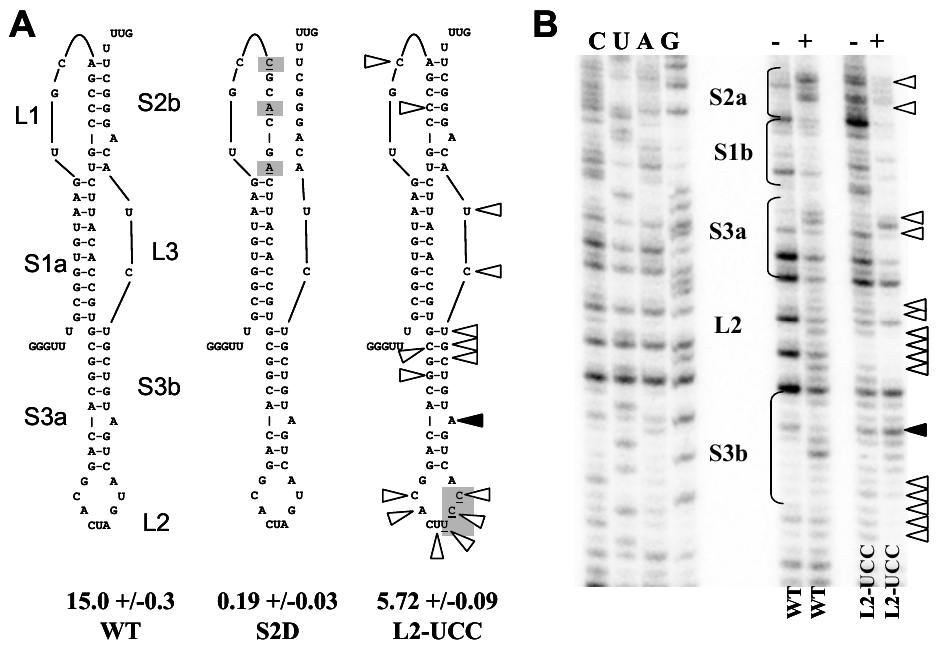
Figure 3. Mutations to stem 3 alter pseudoknot structure. ( A ) The sequence and structure of the wild-type SARS coronavirus pseudoknot is shown on the left (WT). The stems are labeled S1 to S3 with the 5’ portion denoted ‘a’ and the 3’ portion ‘b’. The loops connecting the stems are labeled L1 and L3, and the loop capping the third stem is labeled L2. Changes made to the pseudoknot are shaded and underlined in mutants S2D and L2-UCC. The efficiency of frameshifting as determined by dual luciferase assay is expressed as a percentage below each mutant with standard error shown. ( B ) Comparison of L2-UCC and WT pseudoknots by SHAPE analysis (see Experimental Section). An autoradiograph of the primer extension for the wild-type and L2-UCC pseudoknots is shown. The sequencing ladder is shown on the left side of the gel and SHAPE reactions are shown on the right. Reactions performed with (+) or without (-) NMIA are indicated. The closed carrots show increased reactivity and the open carrots show reduced reactivity. ( C ) Diagrams of pseudoknots with mutations (shaded and underlined) in Stem 3. Asterisks mark the position of deleted adenosines. Frameshifting efficiency is shown below each mutant. Positions of increased or decreased NMIA reactivity are indicated. ( D ) SHAPE analysis of stem 3 mutants. The position of the stems is indicated on the gel, note that because S2 Δ S3 Δ contains deletions the position of the stems differ slightly from the S3D stems. The changes for S2 Δ S3 Δ are indicated on the left and the changes to S3D are indicated on the right of the